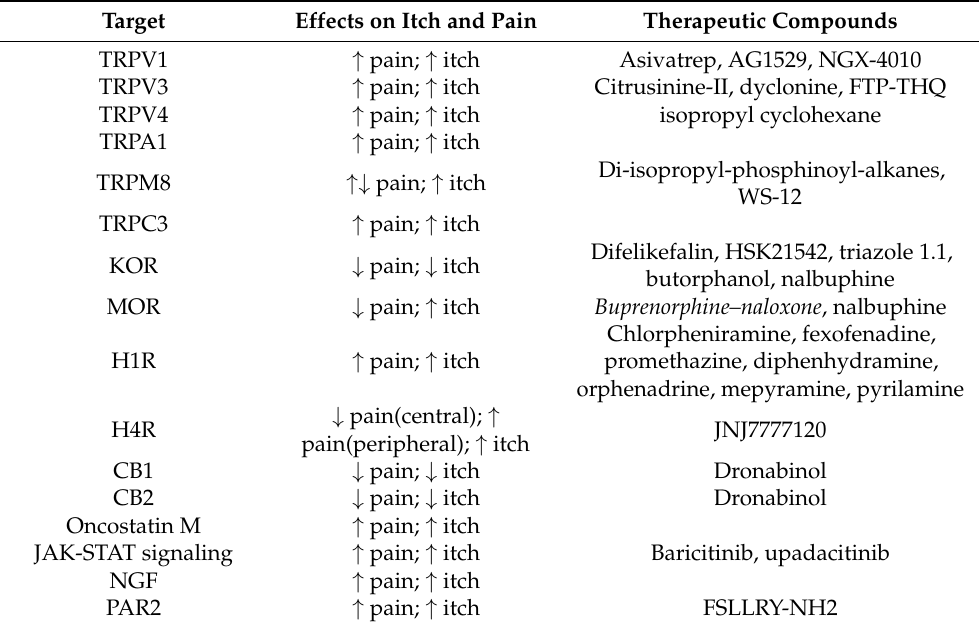
Table 1. Targets and therapeutic compounds with antinociceptive and antipruritic effects. Abbre- viations: KOR—k-opioid receptor; MOR— µ -opioid receptor; H1R—histamine H1 receptor; H4R— histamine H4 receptor; CB1—cannabinoid receptor type 1; CB2—cannabinoid receptor type 2;